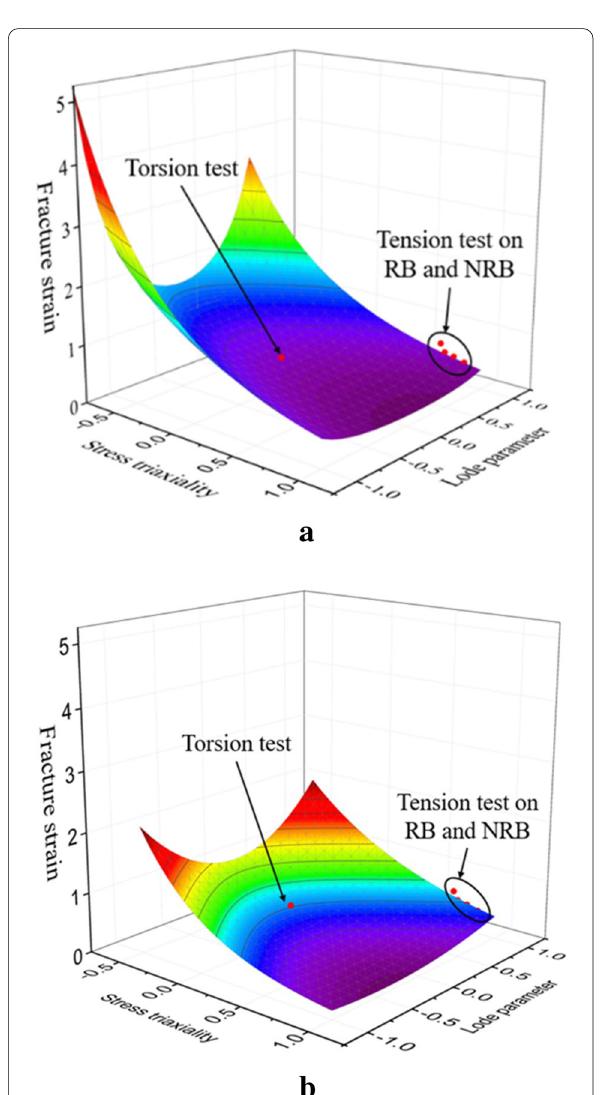
Figure 14 Fracture locus: a MMC model and b Bai-Wierzbicki model